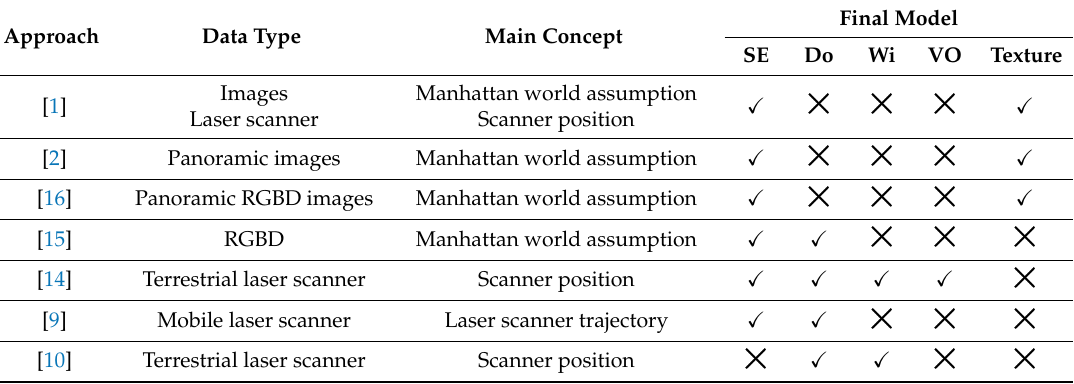
Table 1. Comparison of existing approaches for indoor modelling. SE, structural element; Wo, window; Do, door; and VO, virtual opening; RGBD, red green blue